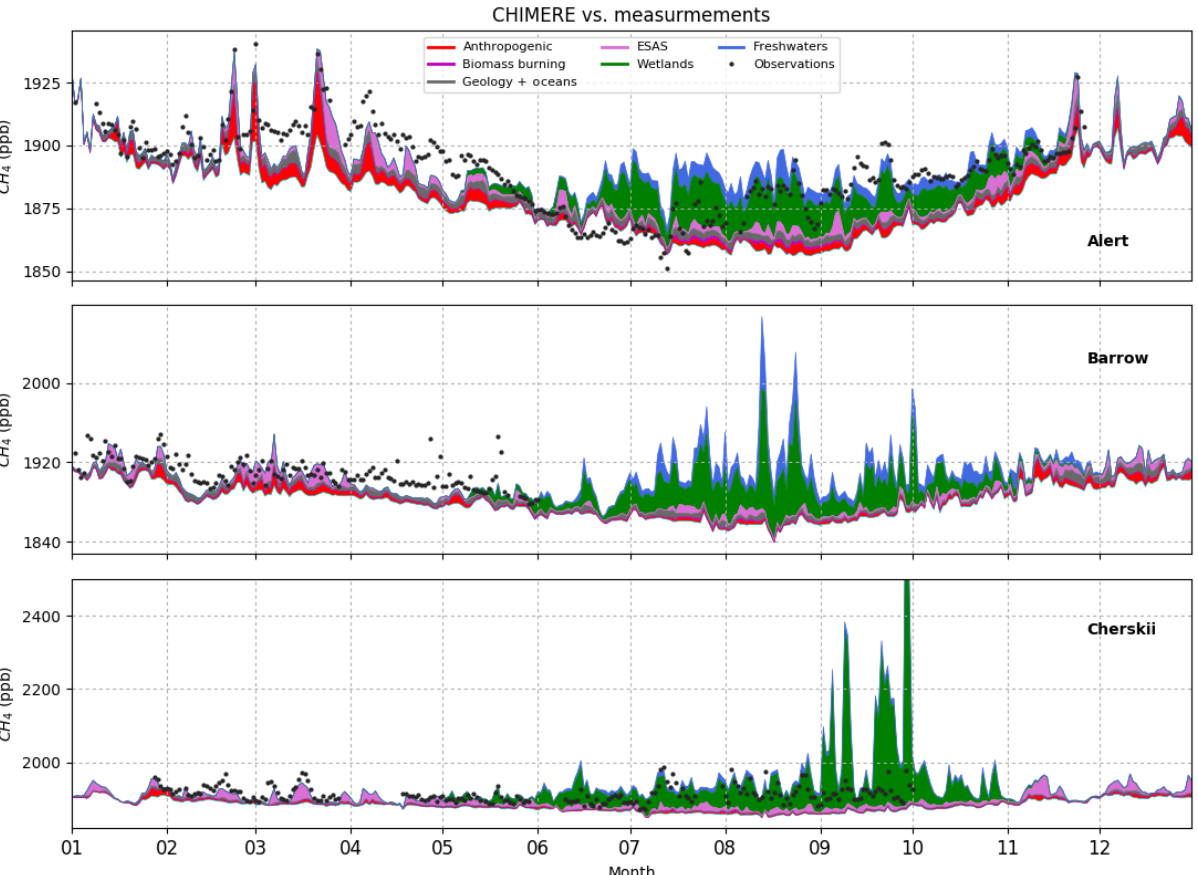
Figure 6. Time series of simulated (in colour) and observed (black points) methane mixing ratios in ppb, at Alert, Barrow, and Cherskii in 2012. The baseline is the contribution of the boundary conditions alone. Time resolution for simulations and observations is 1 day. Maximum for Cherskii CH 4 exceeds the chosen scale limit and reaches 2925ppb. Table 5. Difference between the means of CH 4 calculated during winter (November–May 2012) and summer (June–October 2012). Calcu- lations are made only for days when measurements are available. No data are available in Barrow after May. Winter–summer difference